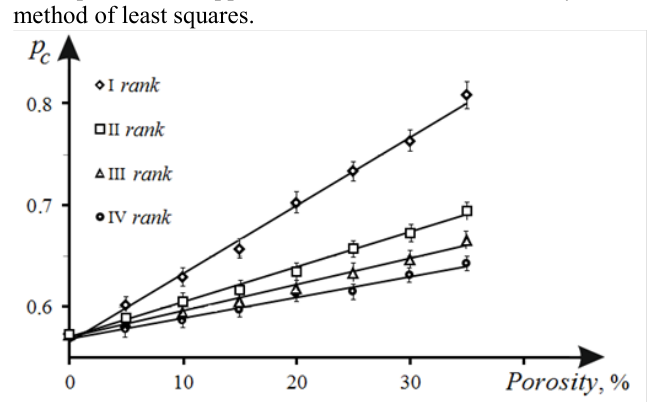
Figure 2. Influence of the pore rank and porosity on the percolation threshold